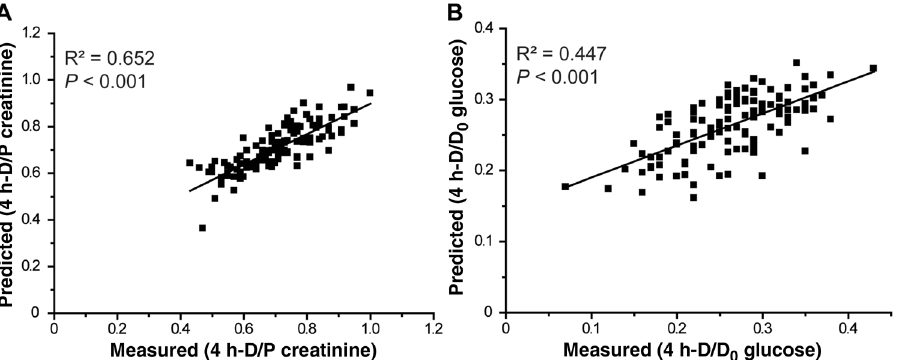
Figure 5. Prediction of measured PET results from total NMR signals. Prediction model between total NMR signals and measured PET results: ( A ) 4 h-D/P creatinine and ( B ) 4 h-D/D 0 glucose. The Y-axis corresponds to the predicted values that were calculated using the PLS regression followed by total NMR signal prediction. The X-axis corresponds to the measured 4 h-D/P creatinine ( A ) and 4 h-D/D 0 glucose ( B ) for determining the PET. The black line represents the best fit between the predicted and observed PET results. PET peritoneal equilibration test, PLS partial least square, NMR nuclear magnetic